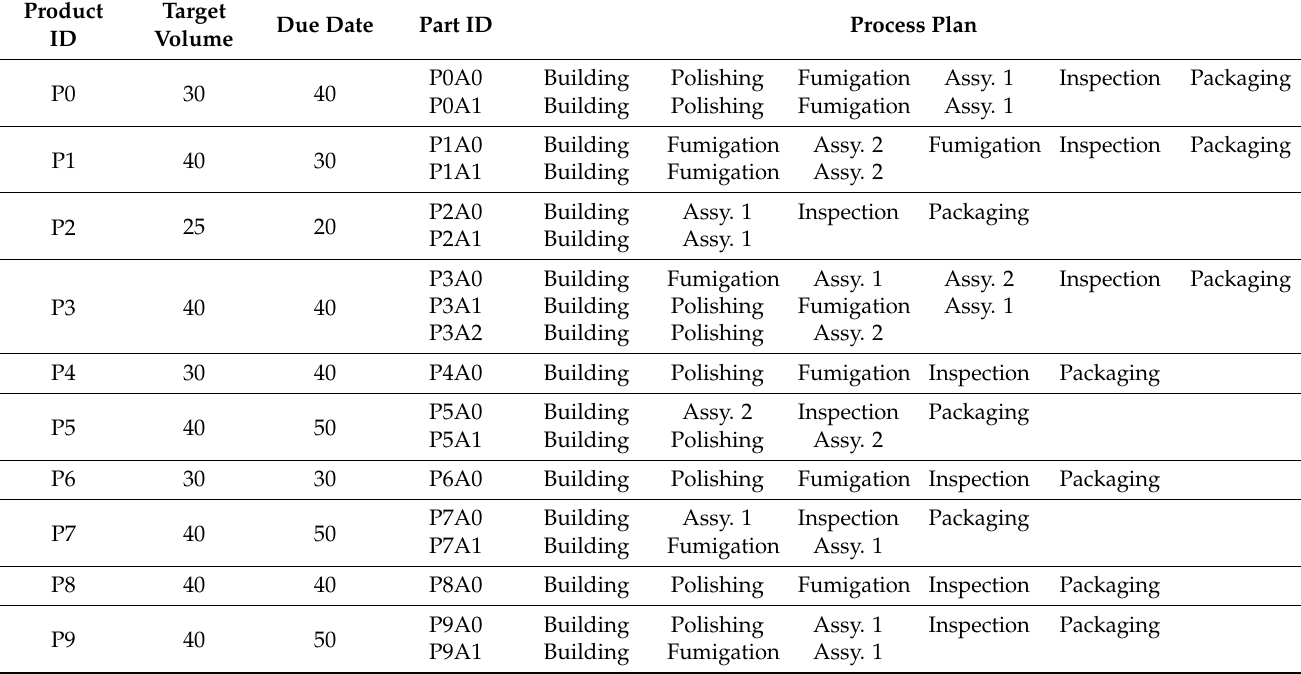
Table 1. Benchmark samples for experiment (time unit: